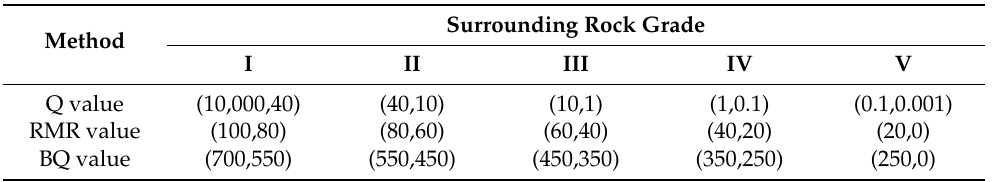
Table 1. Approximate correspondence between the surrounding rock grade in this study and other indices (Q, RMR, and